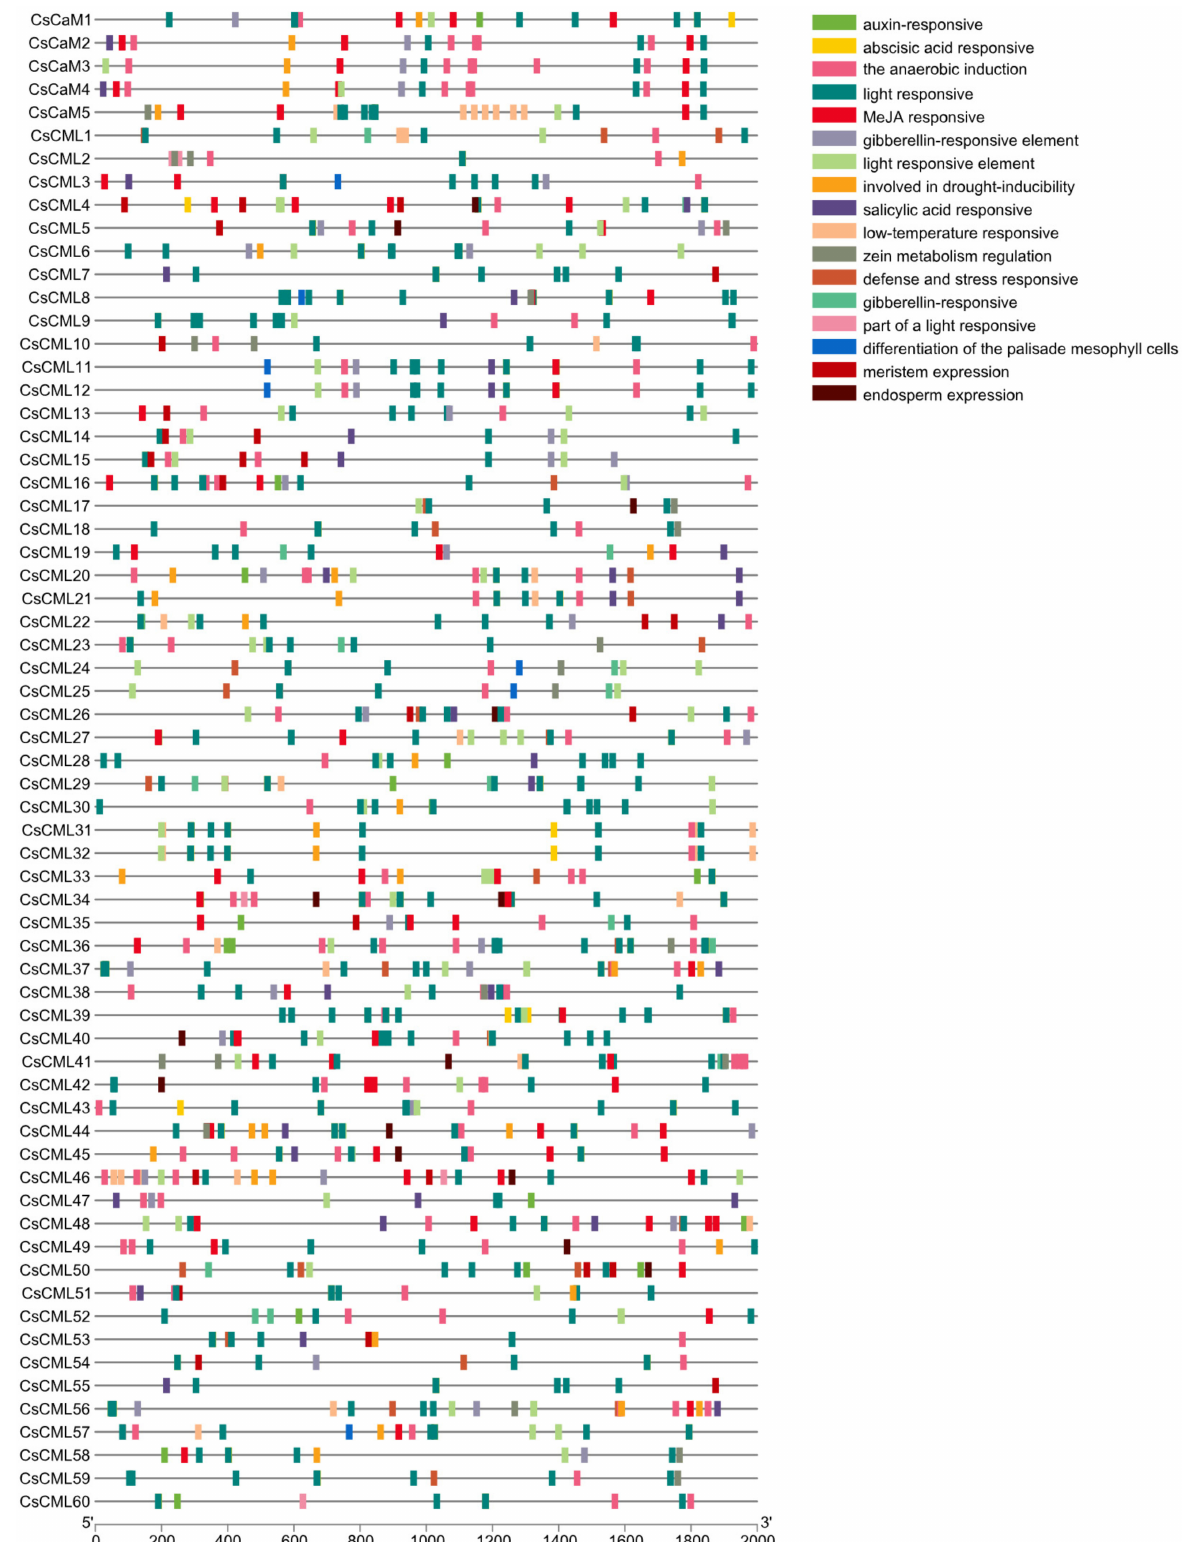
Figure 2. Cis -element analysis of tea CsCaM and CsCML gene promoters. The 2000 bp sequence upstream of the CsCaM/CML start codon was analyzed using online software Plant CARE. Binding sites in the promoter region are represented by boxes of different colors, and the graph shows the number of binding